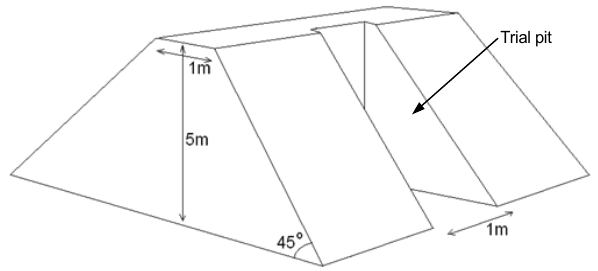
Fig. 4. Typical layout of trial pits in a blast mound